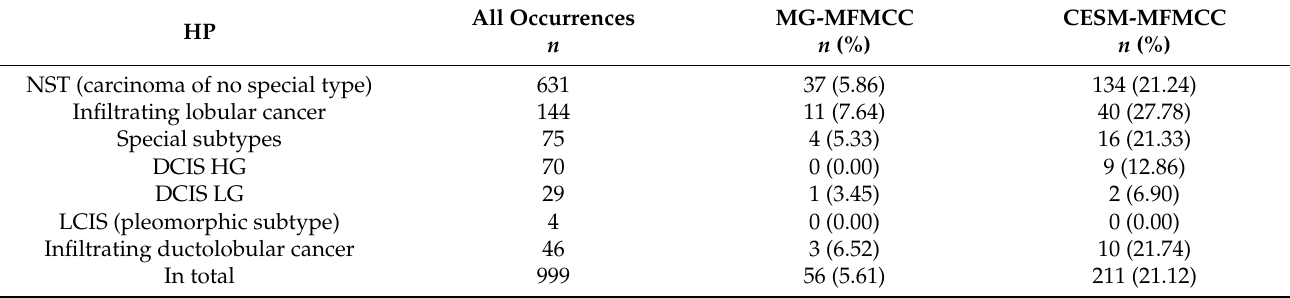
Table 4. Types of cancer in the post-operative histopathological examination (HP) diagnosed as multifocal-multicentric breast cancers (MFMCC) in MG and